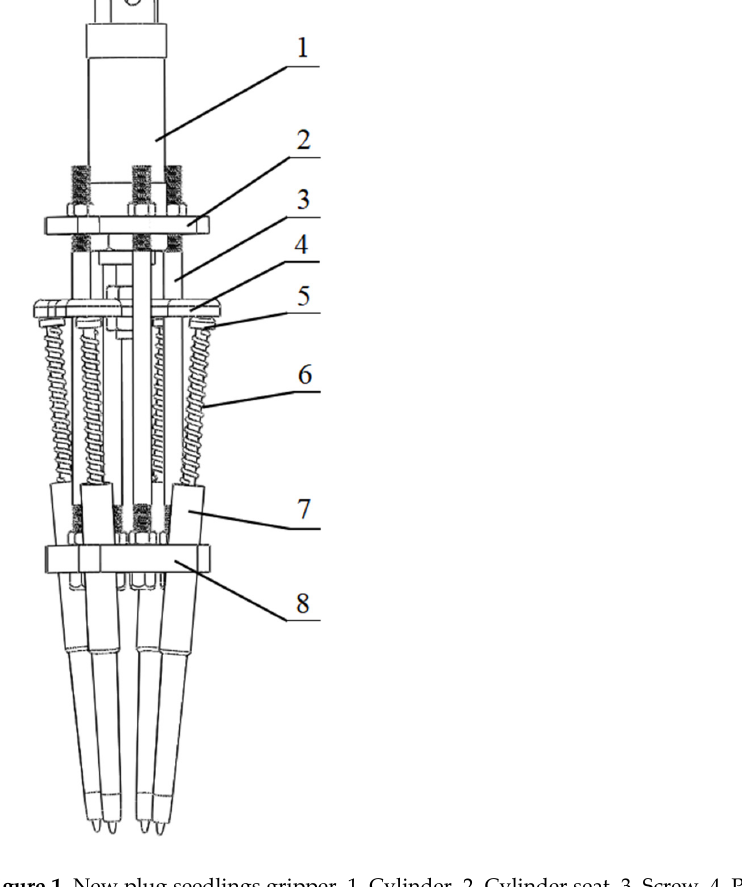
Figure 1. New plug seedlings gripper. 1. Cylinder, 2. Cylinder seat, 3. Screw, 4. Push plate, 5. Steel needle, 6. Spring, 7. Guide tube, 8. Fixing